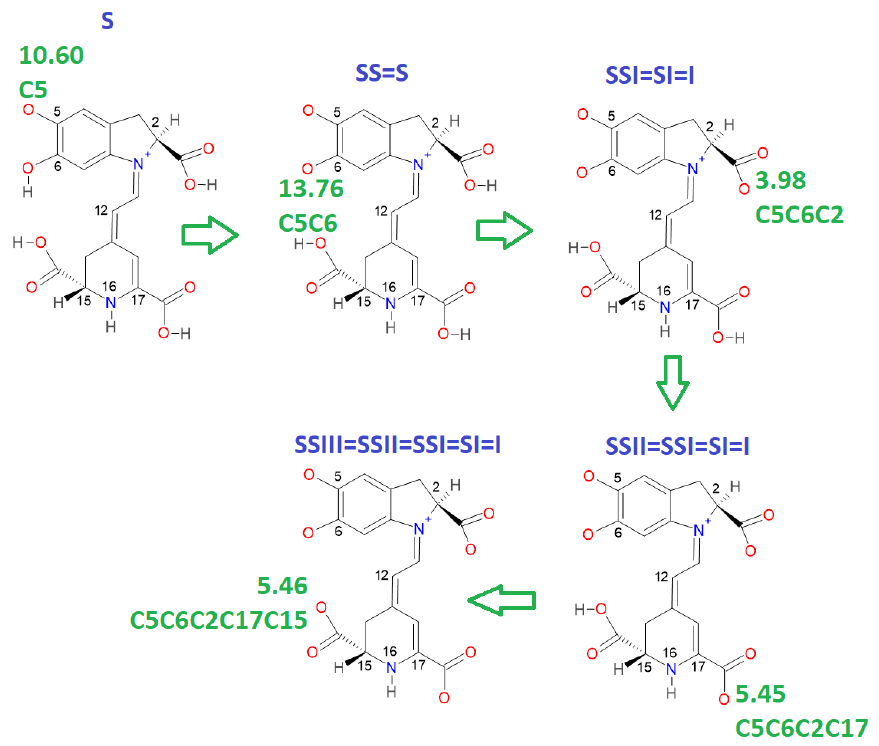
Figure 8. A different deprotonation route involving low pK a in the last stage. The pathway starts on a high value in the first round. The proved statement of Section 2.2 guarantees the result; if the last deprotonation includes a carboxyl group, then the route belongs to the inferior